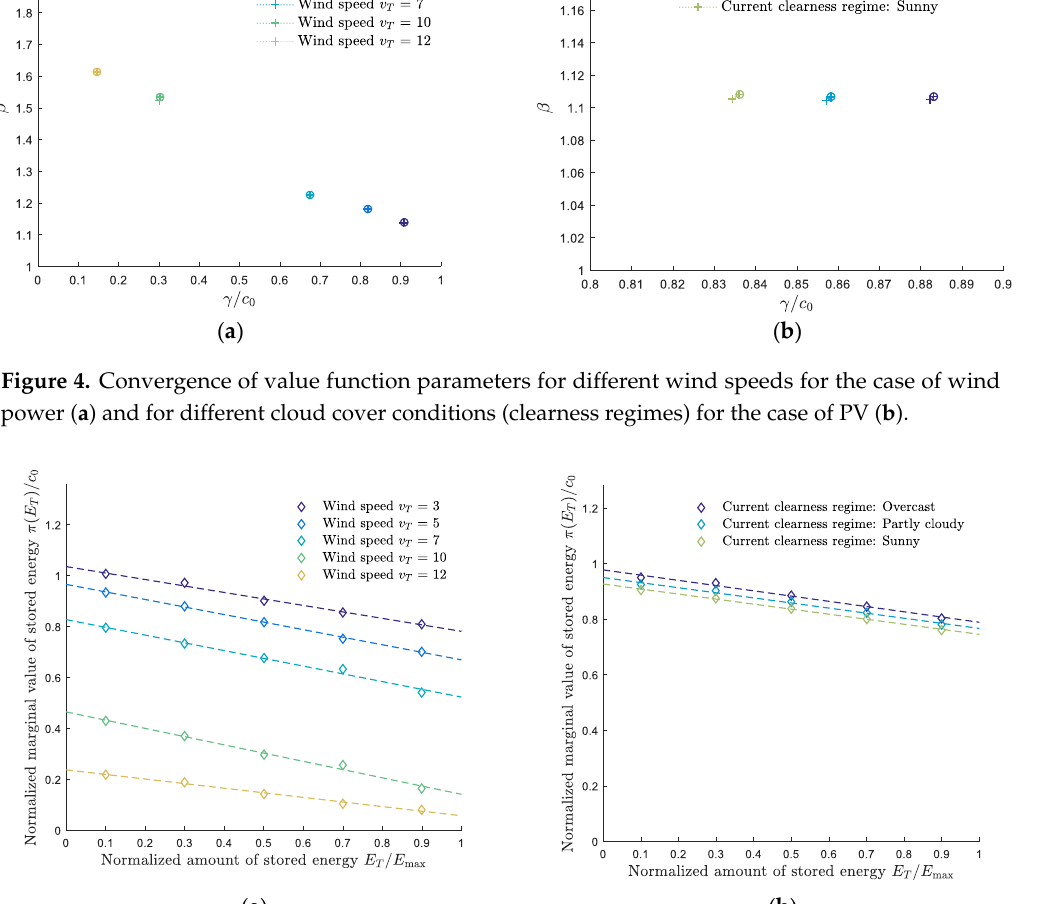
Figure 5. Marginal value of stored energy at the end of the planning horizon as a function of the amount of stored energy for different wind speeds for the case of wind power ( a ) and for different cloud cover conditions (clearness regimes) for the case of PV ( b ).